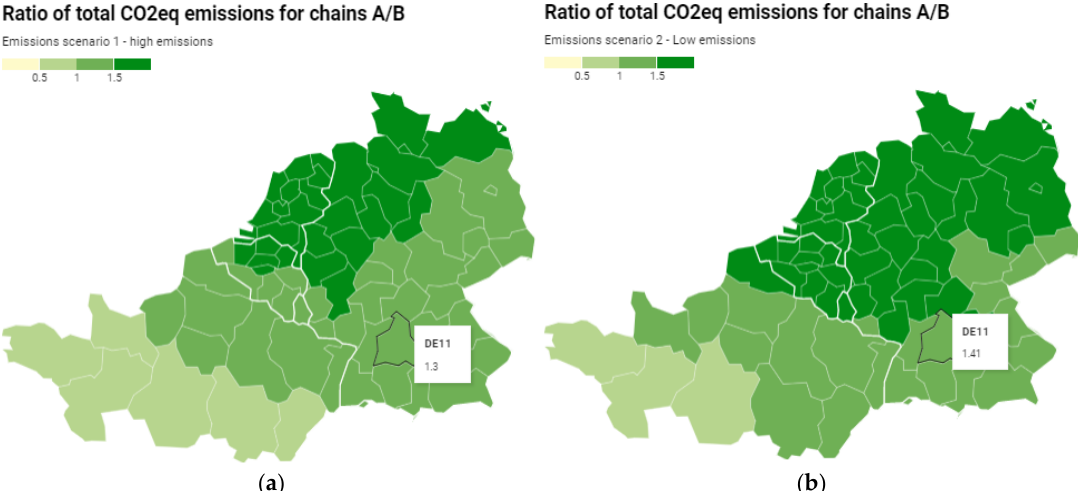
Figure 6. Emissions per country: ( a ) scenario 1; ( b ) scenario 2.